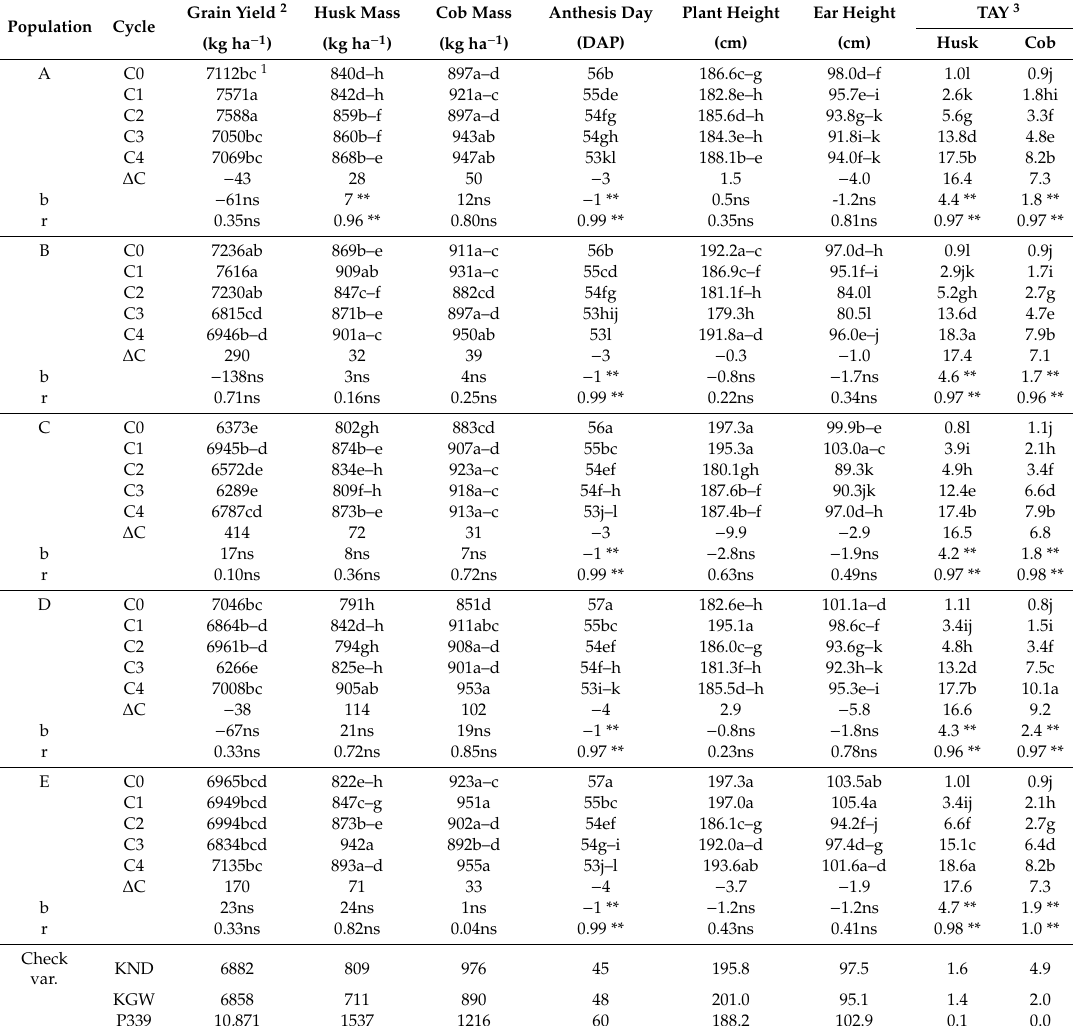
Table 5. Means for grain yield, agronomic traits and total anthocyanin yield (TAY) of (A–E) five populations and (C0–C4) five cycles evaluated across four